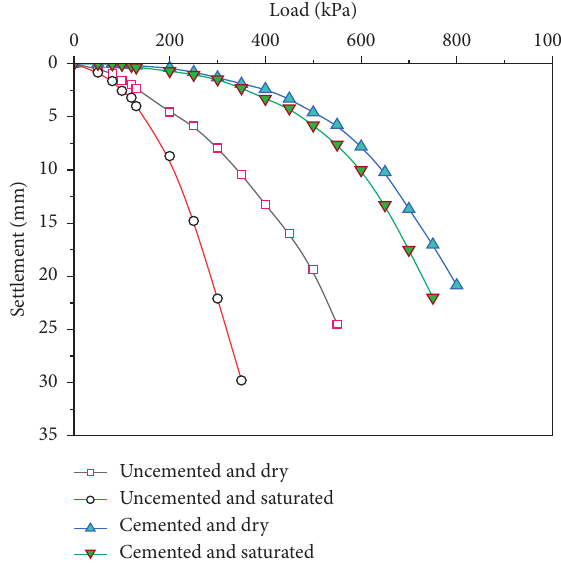
Figure 13: Results of PLTs of dry and saturated